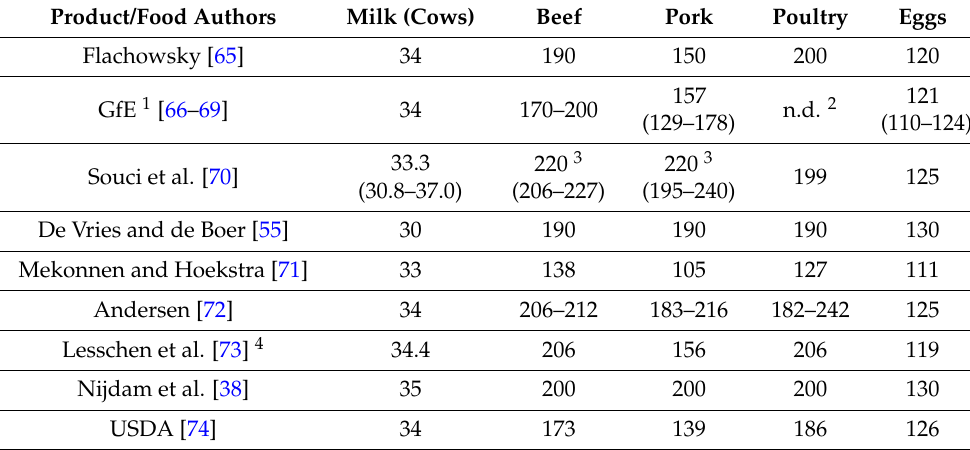
Table 3. Protein content of some edible land animal products/food by various authors (in g per kg edible